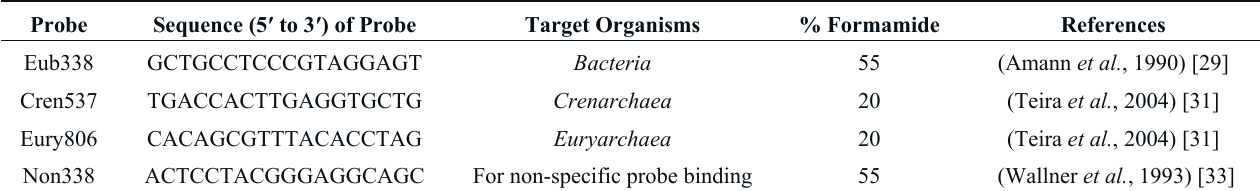
Table 1. 16S rRNA-targeted oligonucleotide probes used in this